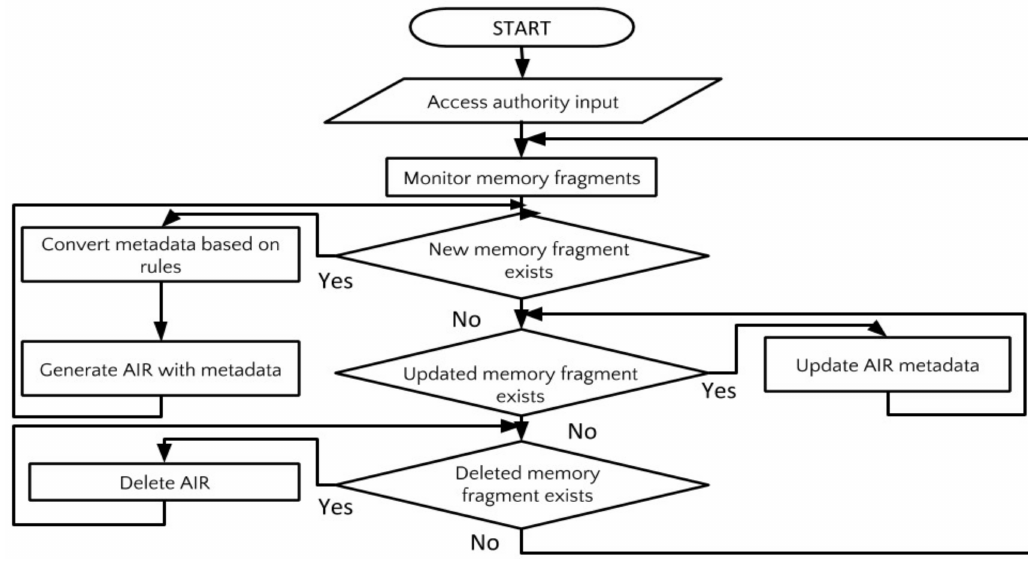
Figure 4. Flowchart of memory fragment activation manager.